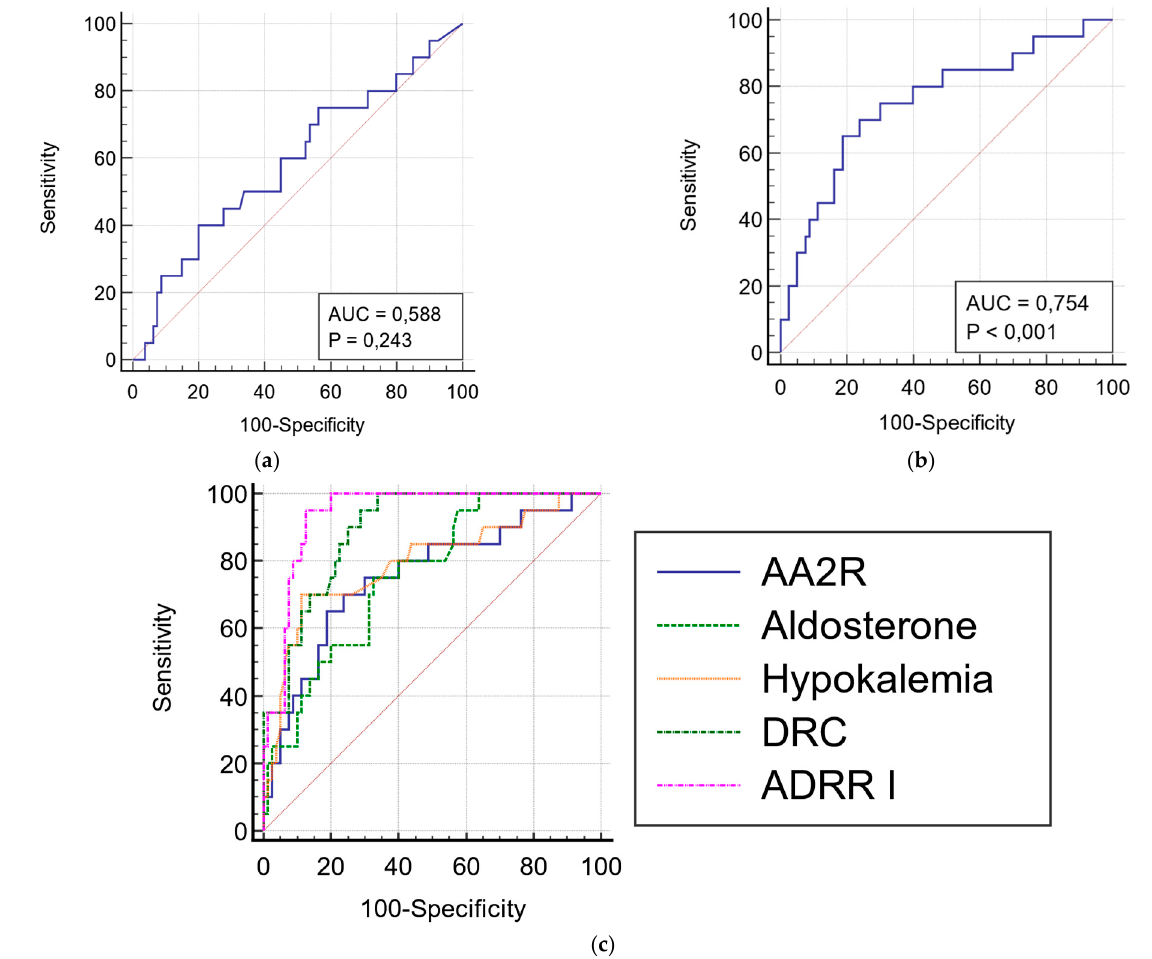
Figure 3. ROCs for ( a ) angiotensin II and ( b ) AA2R; ( c ) comparison of ROCs for ADRR I, AA2R,